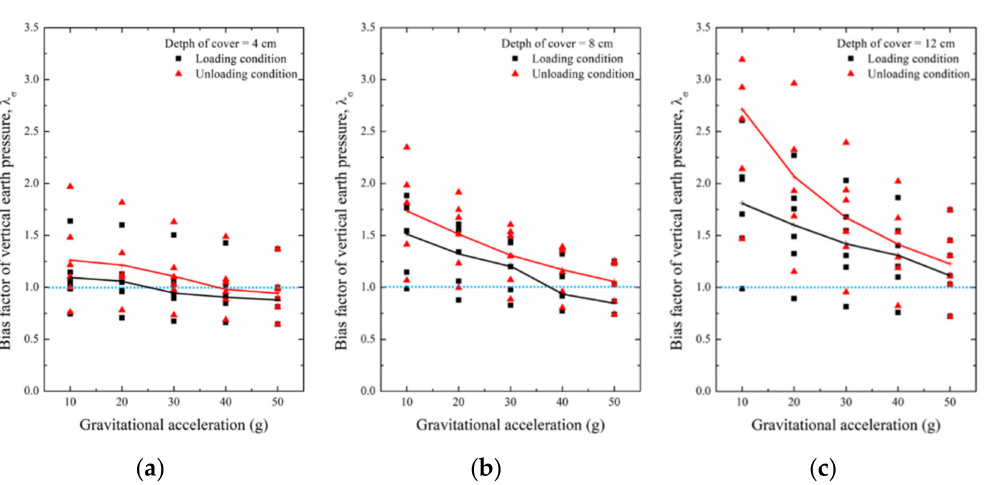
Figure 11. Bias factors of vertical earth pressure at cover depths of ( a ) 4 cm, ( b ) 8 cm, and ( c ) 12